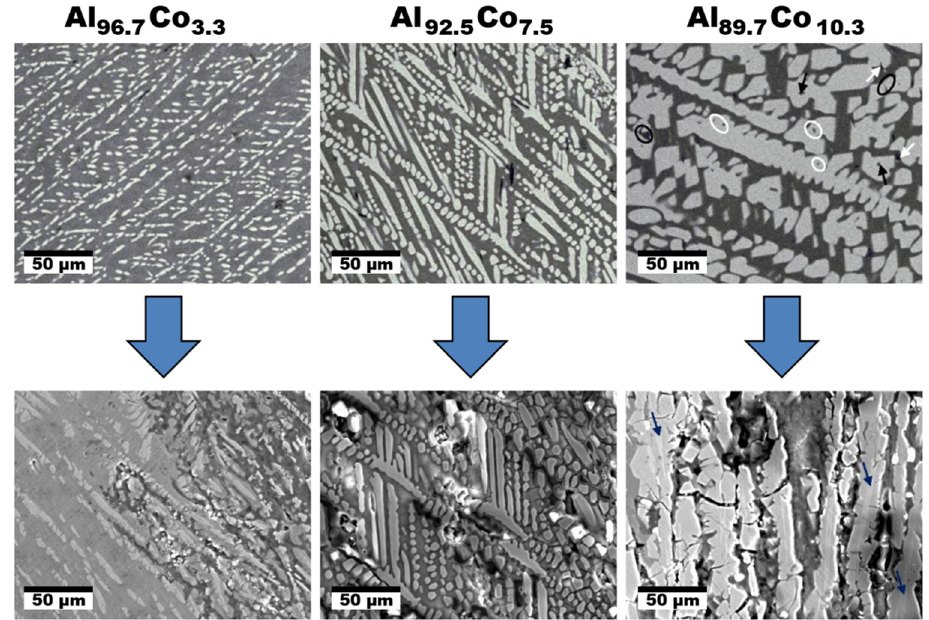
Figure 11. Microstructure of the rapidly solidified Al–Co alloys before and after corrosion in aqueous NaCl, adapted from reference [81].